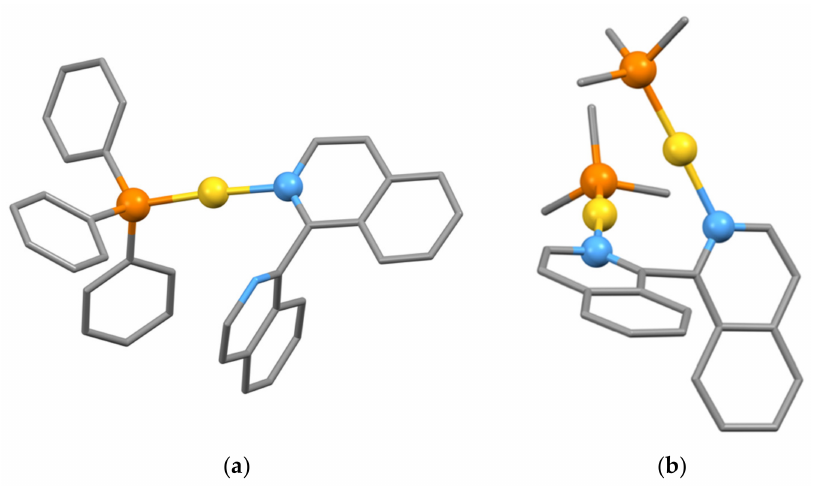
Figure 18. ( a ) In the compound [Au(biiq- κ N )(PPh 3 )](CF 3 SO 3 ) the biiq ligand is monodentate and coordinates to a single near-linear ( ∠ P–Au–N, 175.84 ◦ ), two coordinate gold center with the donor atoms and the gold atoms represented as balls and hydrogen atoms omitted for clarity; ( b ) whereas a bridging mode is found in [(Me 3 P)Au(biiq-1 κ N ,2 κ N ’)Au(PMe 3 )](CF 3 SO 3 ) 2 with the donor atoms and the gold atoms represented as balls and hydrogen atoms omitted for